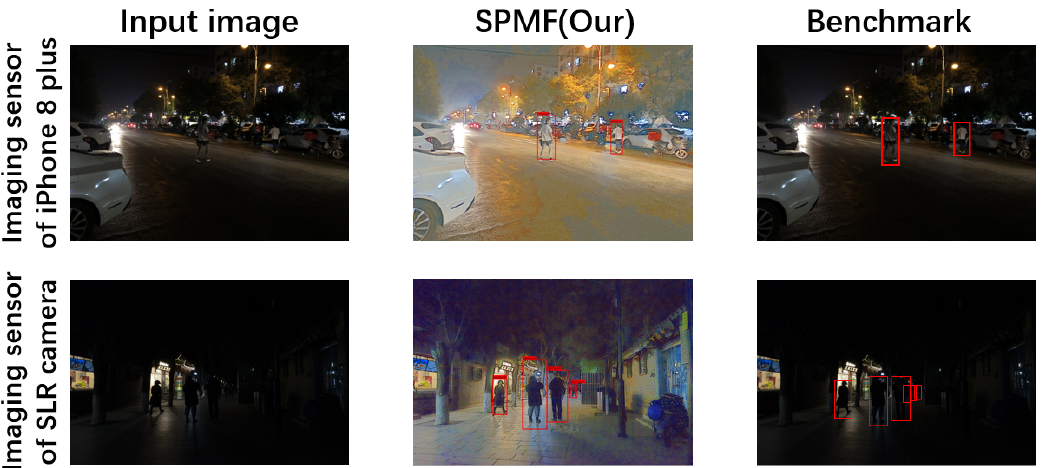
Figure 8. The visual results on real-world